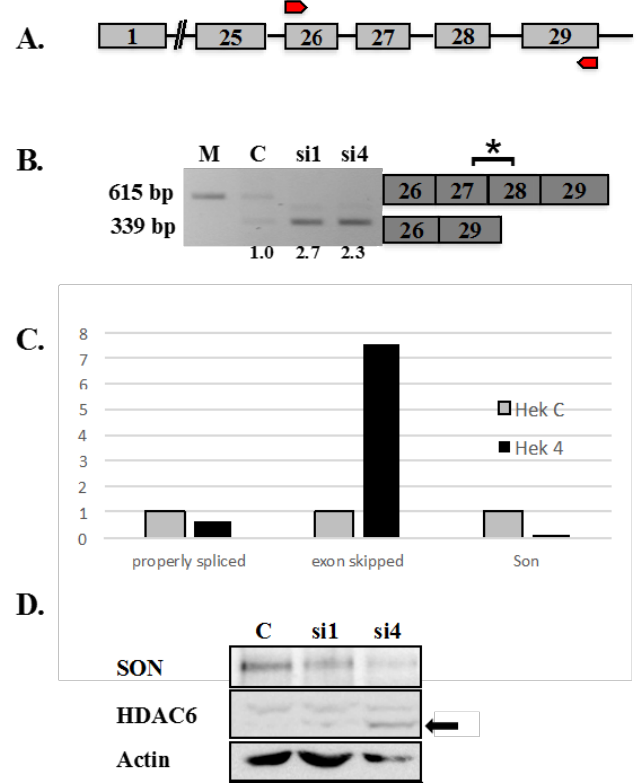
Figure 1. Altered splicing of HDAC6 pre-mRNA in SON depleted HeLa cells. ( A ) Human HDAC6 contains 29 exons represented as boxes and the intervening introns represented as lines joining exons. Red arrows represent the region of genomic DNA used to construct HDAC6 minigene reporter plasmid shown in Figures 2–4; ( B ) RT-PCR performed using primers that amplify endogenous HDAC6 transcripts shows exon skipping in SON siRNA-treated samples compared to mock (M) and control (C). Boxes to the right indicate the region of HDAC6 transcripts detected by RT-PCR. Asterisk indicates exons 27 and 28 are skipped in SON-depleted cells. Numerical values below lanes represent the ratio of transcripts having retained:excluded introns; ( C ) Human embryonic kidney cells treated with either control siRNAs or si4 siRNA duplex targeting SON (Hek 4) were used for qRT-PCR with HDAC6 exon-junction oligos. SON depleted cells showed significantly reduced expression of SON transcripts (Son) as well as reduction of properly spliced HDAC6 transcripts, but showed increased skipping of exons 27 and 28 (exon skipped) for endogenous HDAC6 transcripts; and ( D ) HeLa cells were transfected with control siRNA oligo (C) and two different siRNA oligos targeting SON. Forty-eight hours post- transfection, protein was extracted and immunoblotting was performed with antibodies against SON (WU09), HDAC6 and actin. Western blot confirmed reduced SON protein in cells treated with siRNA duplexes targeting SON. Arrow indicates that the molecular mass of HDAC6 is 10 kDa smaller following treatment with siRNA targeting SON compared to control siRNA treated